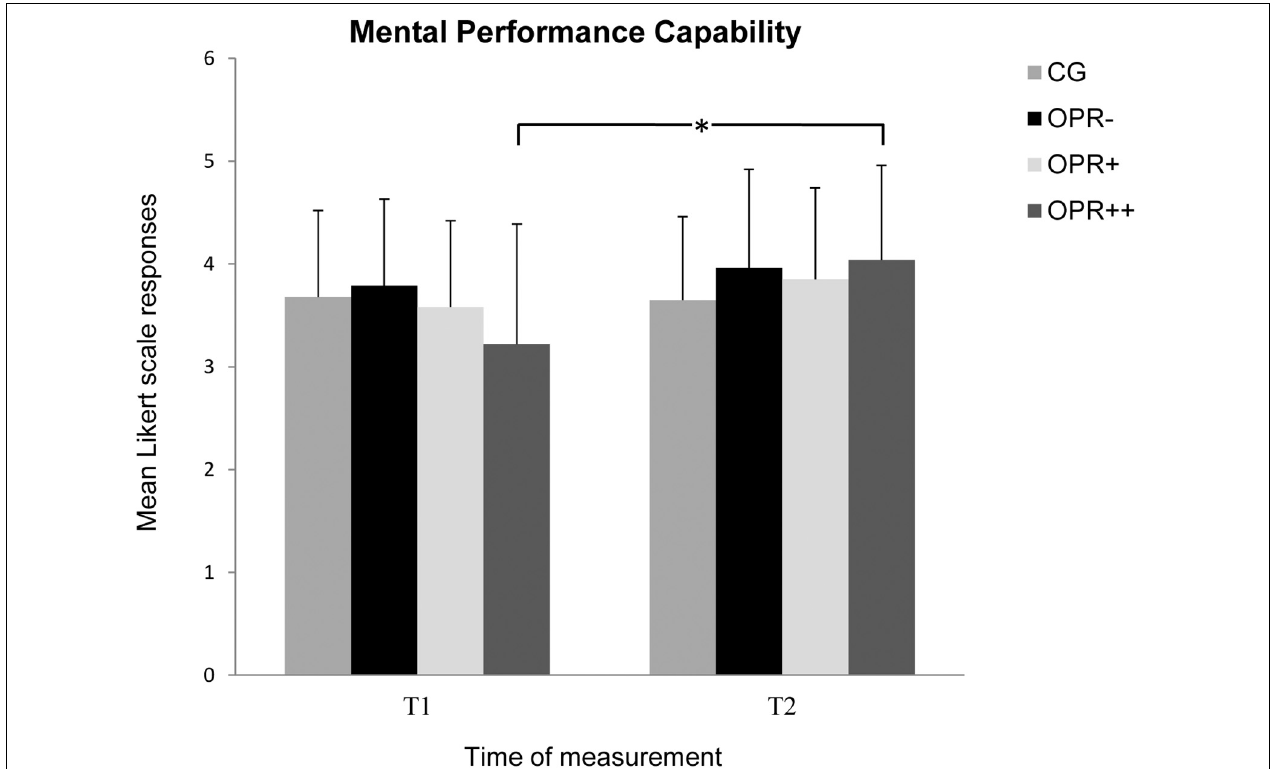
FIGURE 3 | The mean values of the Mental Performance Capability of the groups as a function of time of measurement (T1, T2). The symbols represent across-participant means, and error bars show standard deviations. The 7-point Likert scale ranged from “does not apply at all” (0) to “fully applies” (6). (CG: control group without any intervention; OPR - group: got a filled bottle of water every day without any label on it; OPR + group: got a filled bottle of water every day with the label “Imagine I Am Health”; OPR ++ group: got a filled bottle of water every day with the label “Imagine I Am Health” and an audio file with a health mediation) (*p <